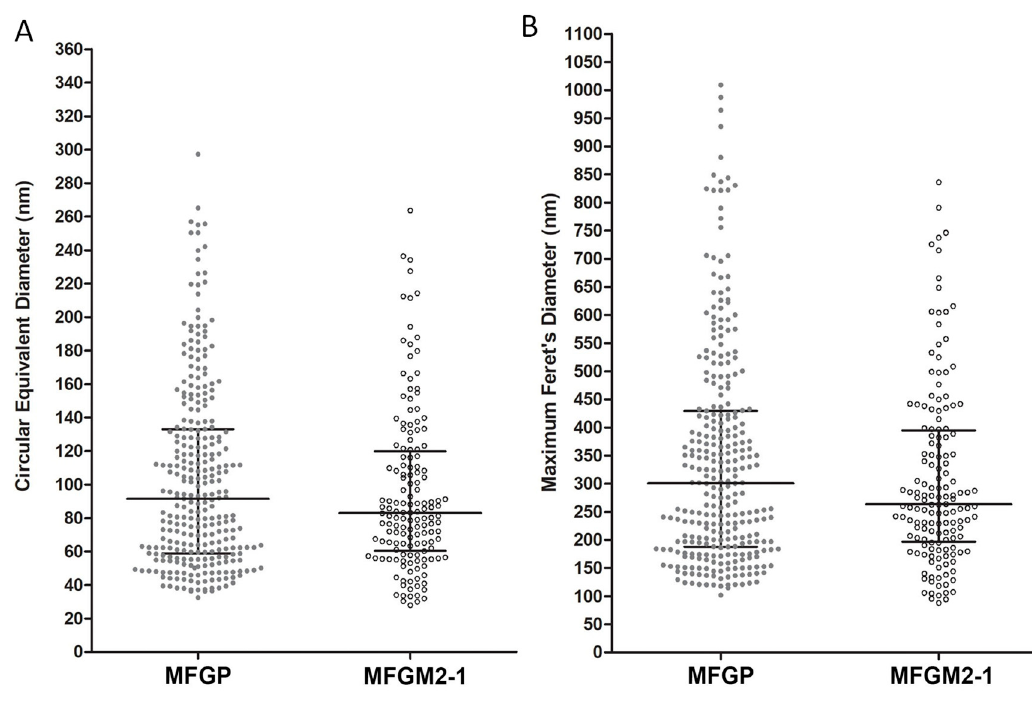
Figure 3. Size distribution of MFGP and MFGM2-1 VLPs. Morphological analysis was performed on MGFP and MFGM2-1. Circular equivalent diameter ( A ) and maximum Feret’s diameter ( B ) were measured and analyzed from negative stain electron microscopy images of MFGP ( n = 295) and MFGM2-1 ( n = 151). Median and interquartile ranges are shown in the graph. The median of the circular equivalent diameter is 91.6 nm for MFGP, and 83.05 nm for MFGM2-1. The median of the maximum Feret’s diameter is 300.8 nm for MFGP, and 263.4 nm for MFGM2-1.